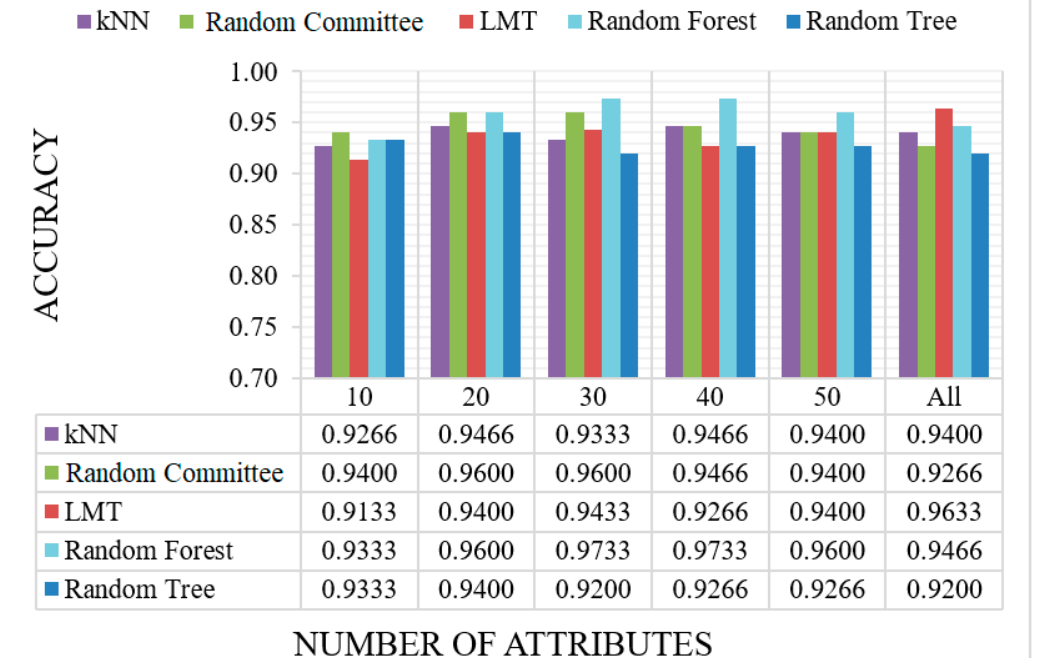
Figure 7 . The accuracy results of the ML models on cancer prediction with different numbers of attributes. (Illustrations by the authors) .